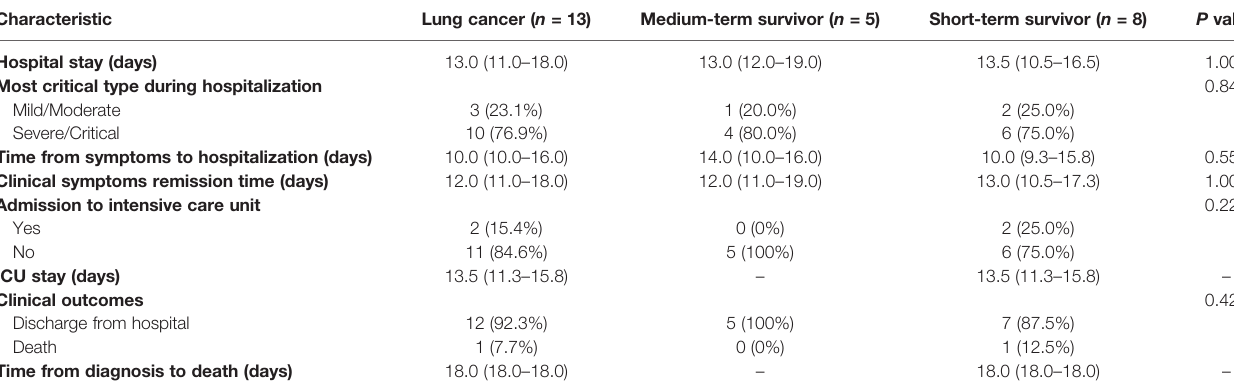
TABLE 3 | Outcome of medium-term and short-term lung cancer survivor.